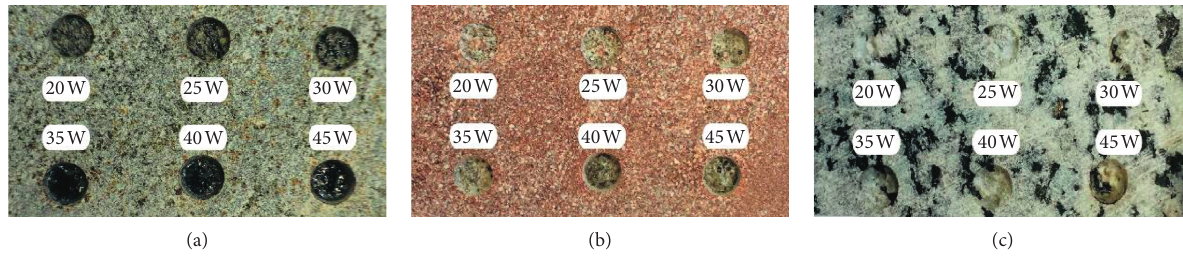
Figure 11: Morphologies of laser perforated rock under different laser power. (a) Basalt. (b) Sandstone. (c) Granite.